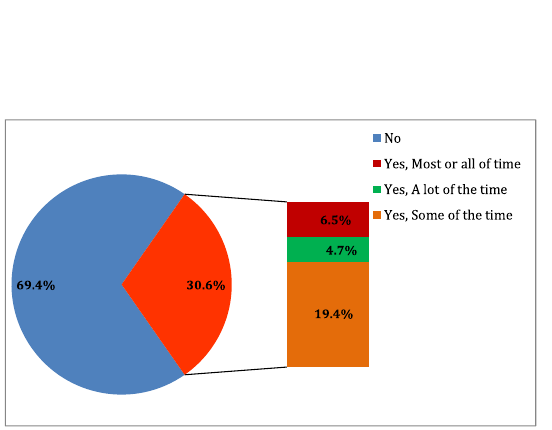
Figure 1. Prevalence of tinnitus. Prevalence of tinnitus among the studied sample and the frequency of tinnitus over the past year (n =